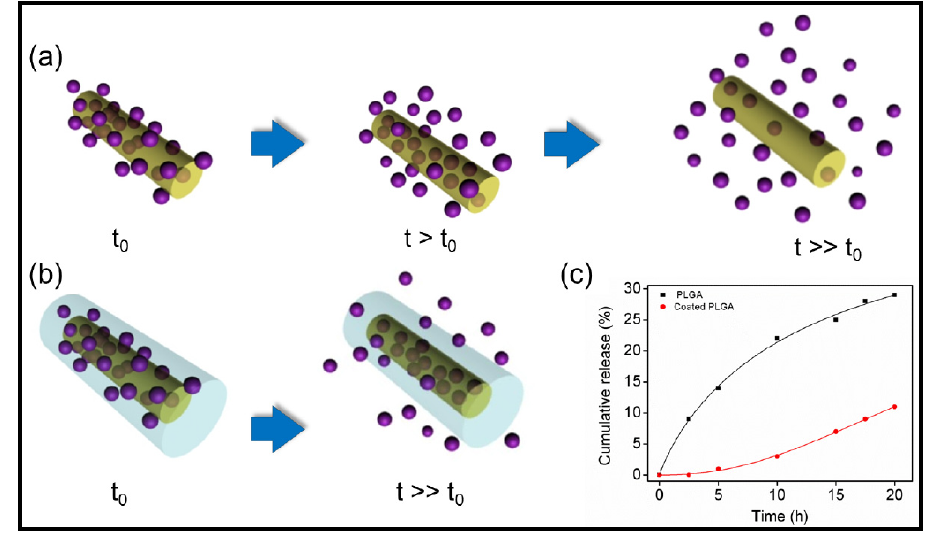
Figure 27. Schematic illustration showing the release of the anti-inflammatory drug from electrospun nanofibers ( a ) without and ( b ) with an alginate hydrogel coating; ( c ) Comparison of cumulative mass release profiles of DEX-loaded PLGA scaffolds with and without the alginate coating. Reprinted with permission from [125]. Copyright 2009 WILEY-VCH Verlag GmbH &